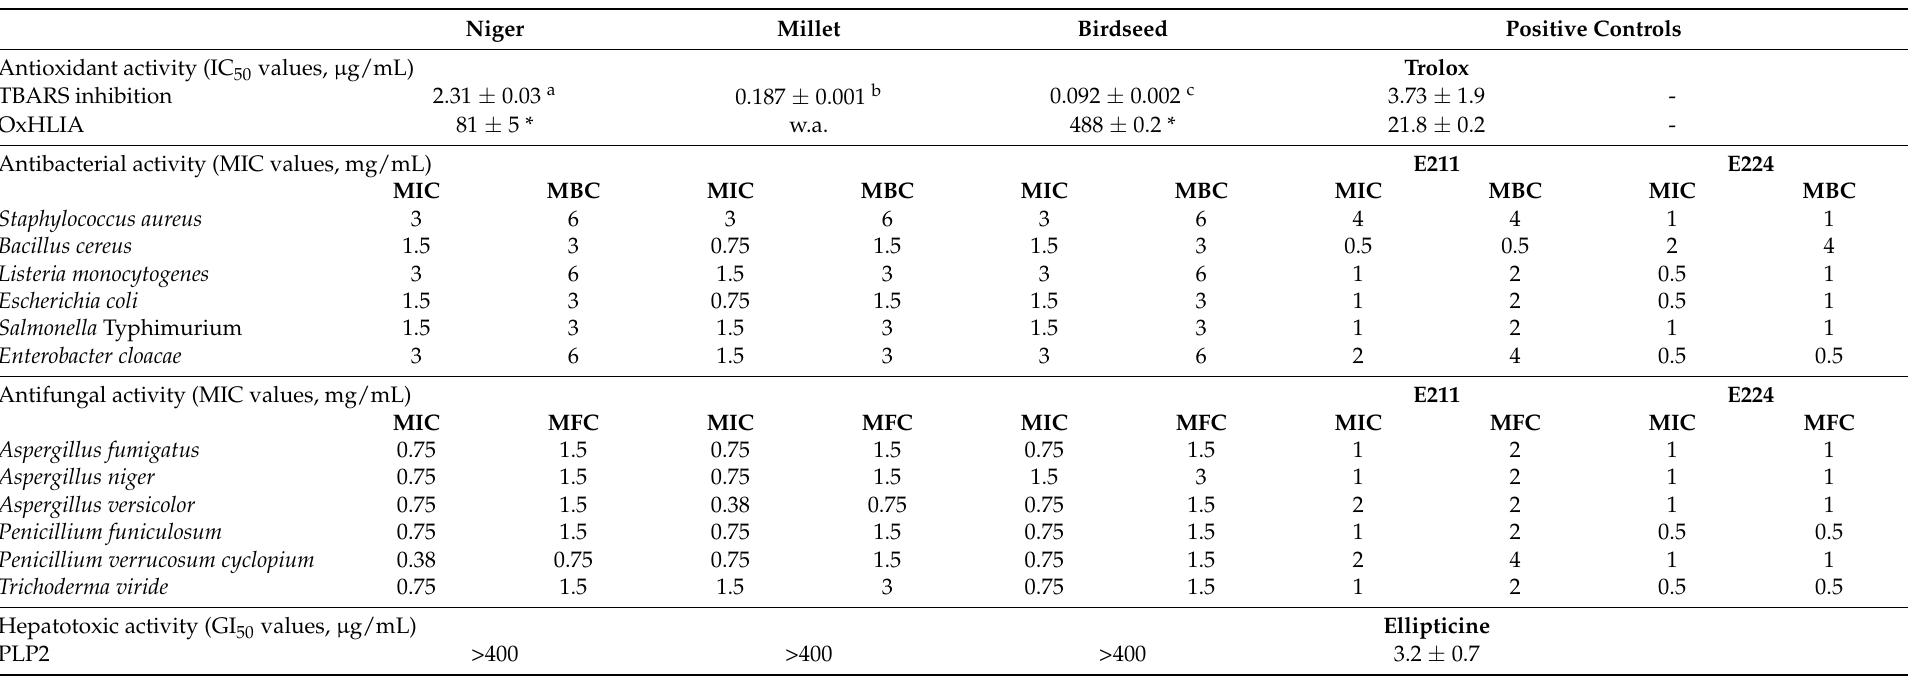
Table 5. Antioxidant and antimicrobial activity of the hydroethanolic extracts of niger, millet and birdseed (mean ± SD).